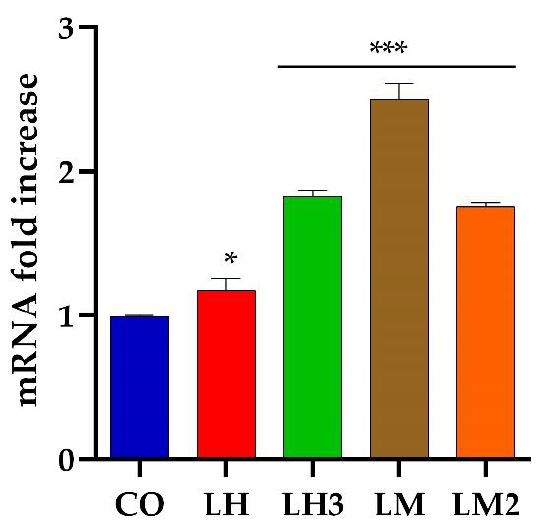
Figure 6. Expression level analysis of vegfa as an angiogenesis marker: Embryos were treated with purified extracts from H. aspersa (LH, LM, LH3, and LM2) and analyzed at 48 hpf. Gene expression was normalized using rpl13a as a reference gene and expressed as the mRNA fold increase. Data are representative of three replicates, and are shown as the mean ± standard deviation; *** p < 0.001 vs. control group; * p < 0.05 vs. control group. Statistical analysis was performed with GraphPad version